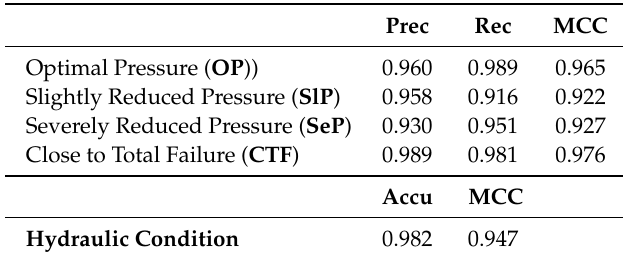
Table 7. Classification results for the Hydraulic Accumulator condition at the state and multiclass classifier